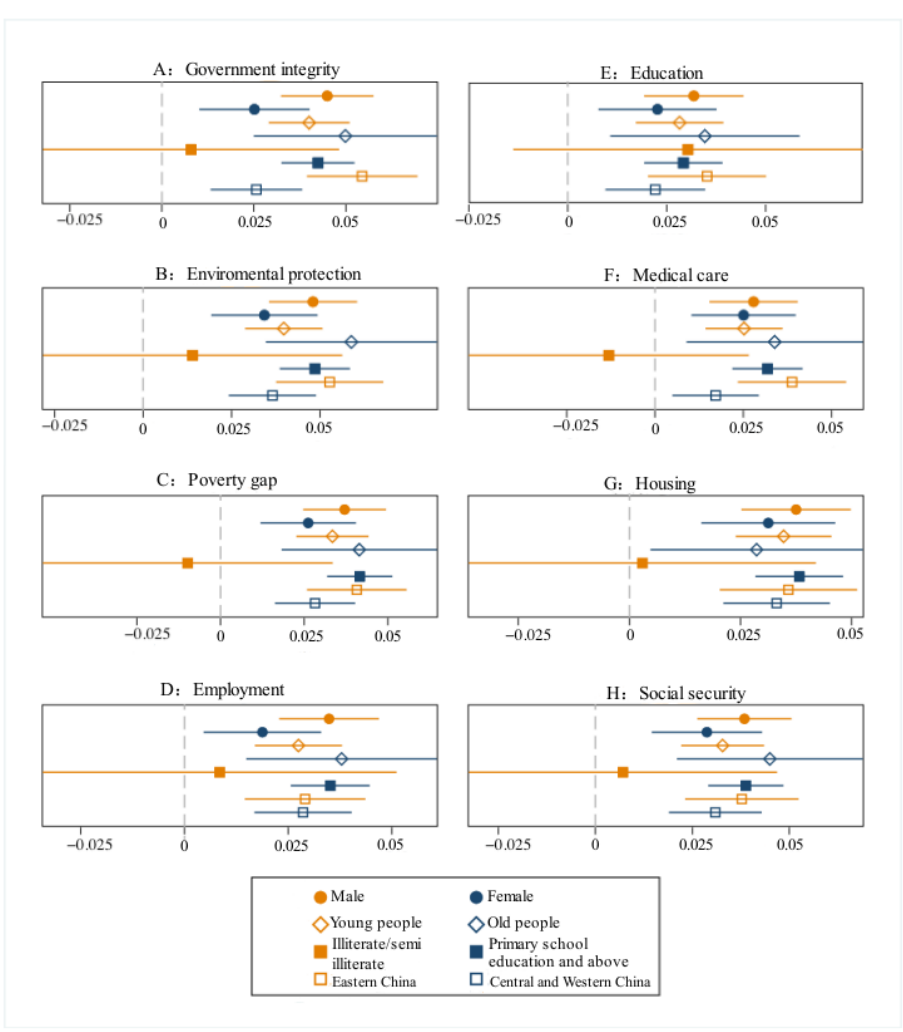
Figure 5. Differences in the impact of Internet use on the satisfaction with social environment among different groups.